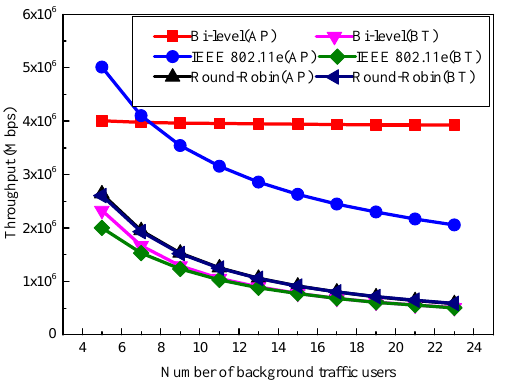
Fig. 4. Throughput of AP and the average throughput of background traffic users versus the number of background traffic